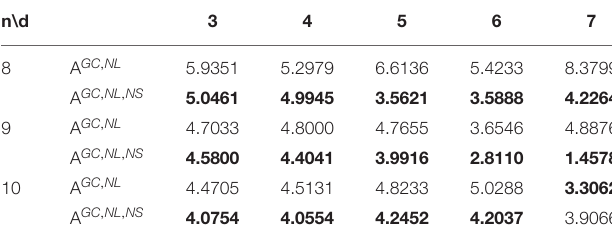
TABLE 11 | Comparison of the variance of Tm.